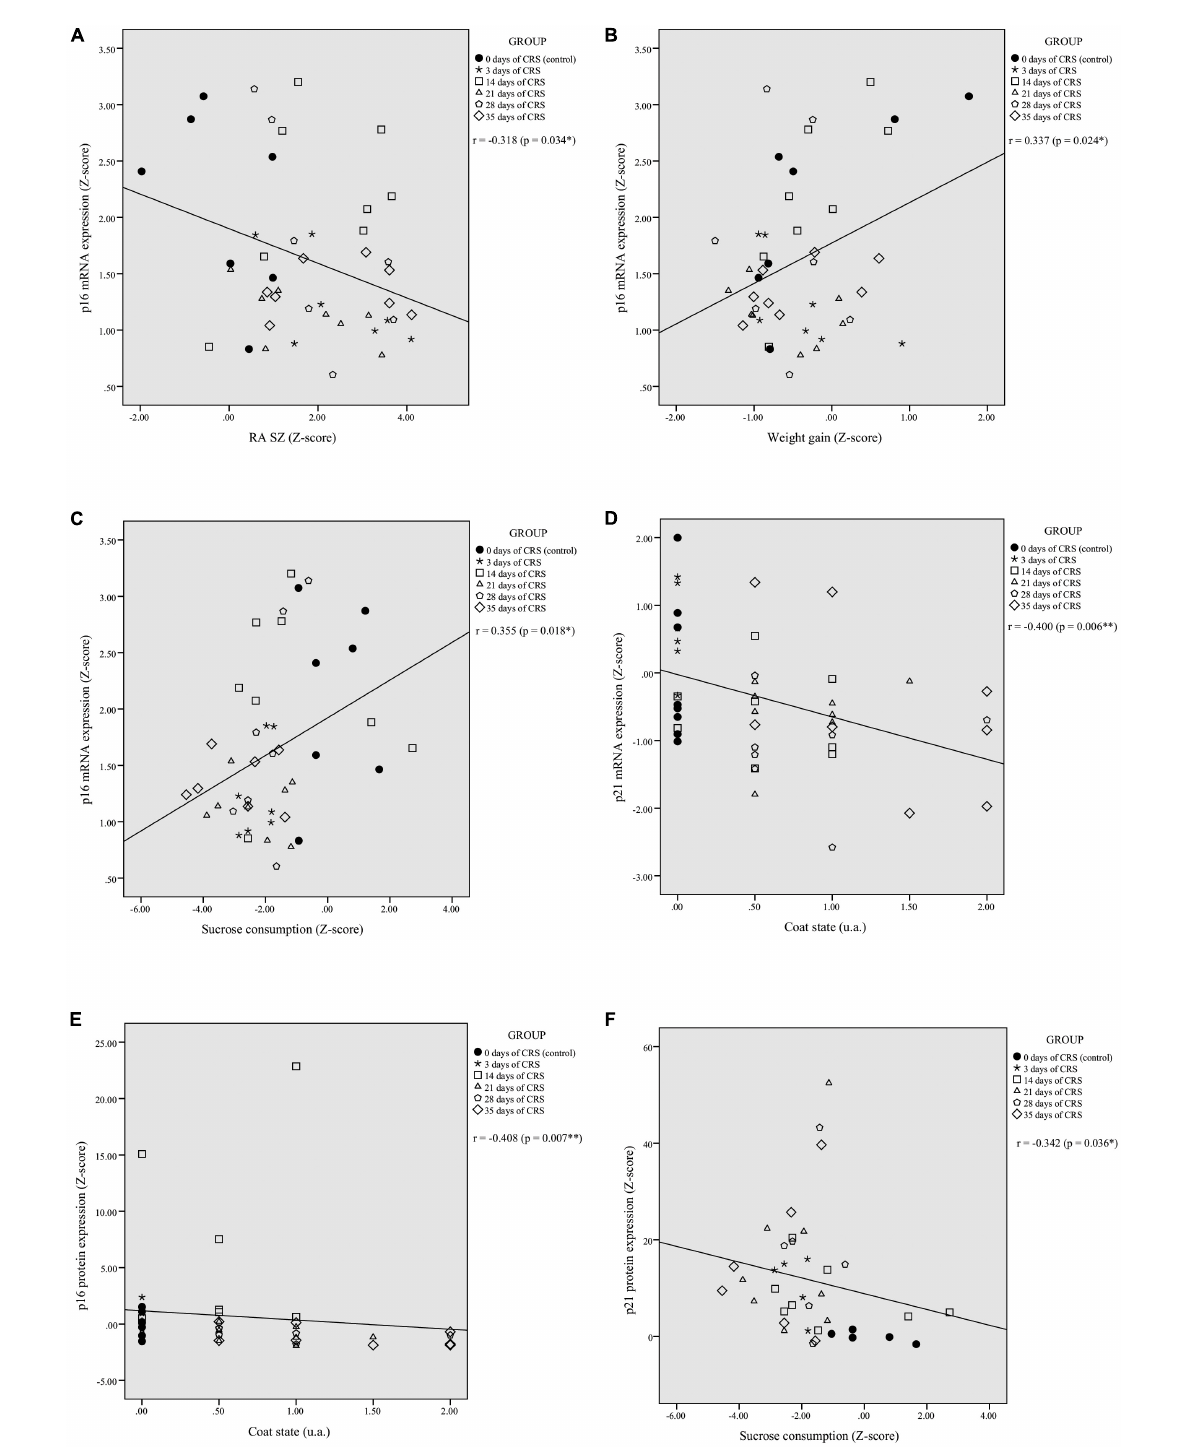
FIGURE2 Chronic restraint stress (CRS)-induced alterations in PFC p16 INK4a and p21 Waf1 / Cip1 mRNA and protein expression levels correlates with behavioral performances. The p16 INK4a mRNA expression levels were significantly correlated with residual avoidance in shelter zone (RA SZ) (A) , weight gain (B) , and sucrose consumption (C) . The p21 Waf1 / Cip1 mRNA levels showed a significant negative correlation with coat state (D) . The p16 INK4a protein expression levels were negatively correlated with coat state (E) and the p21 Waf1 / Cip1 protein expression levels were negatively correlated with sucrose consumption (F) . * p < 0.05, ** p <